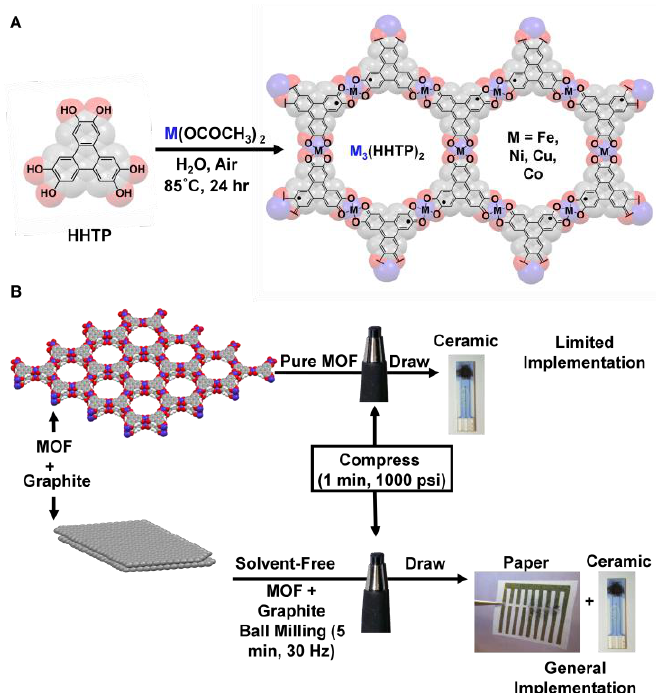
Figure 1. Synthesis of metal-organic frameworks (MOFs) and fabrication of sensors. ( A ) The synthetic scheme for the series of two-dimensional (2D) MOFs used in this study. ( B ) A schematic showing the stepwise process for integration of MOF-based materials into chemiresistive devices.